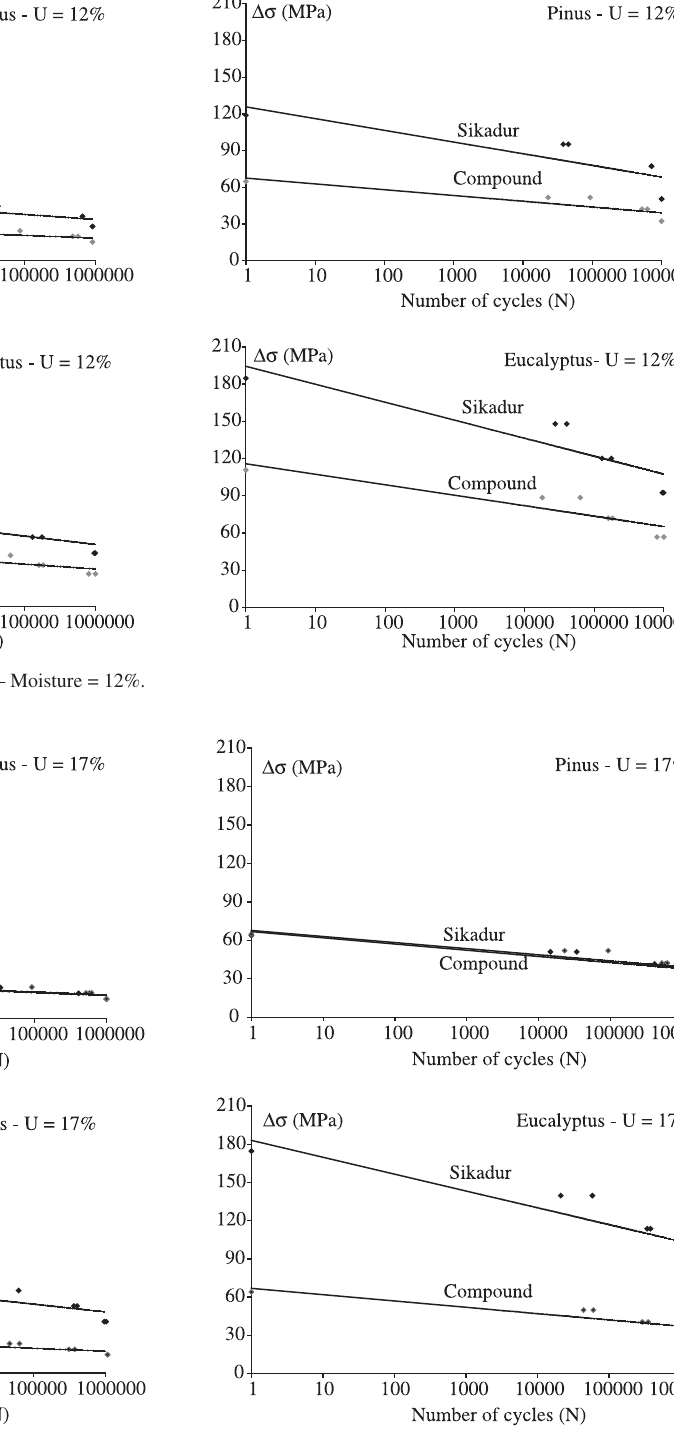
Figure 6. Fatigue performance of the epoxy adhesives – Moisture =